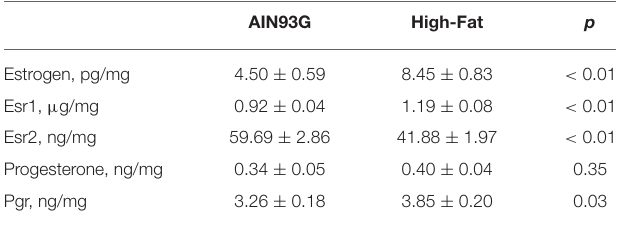
N = 70 each for the AIN93G and the high-fat diet